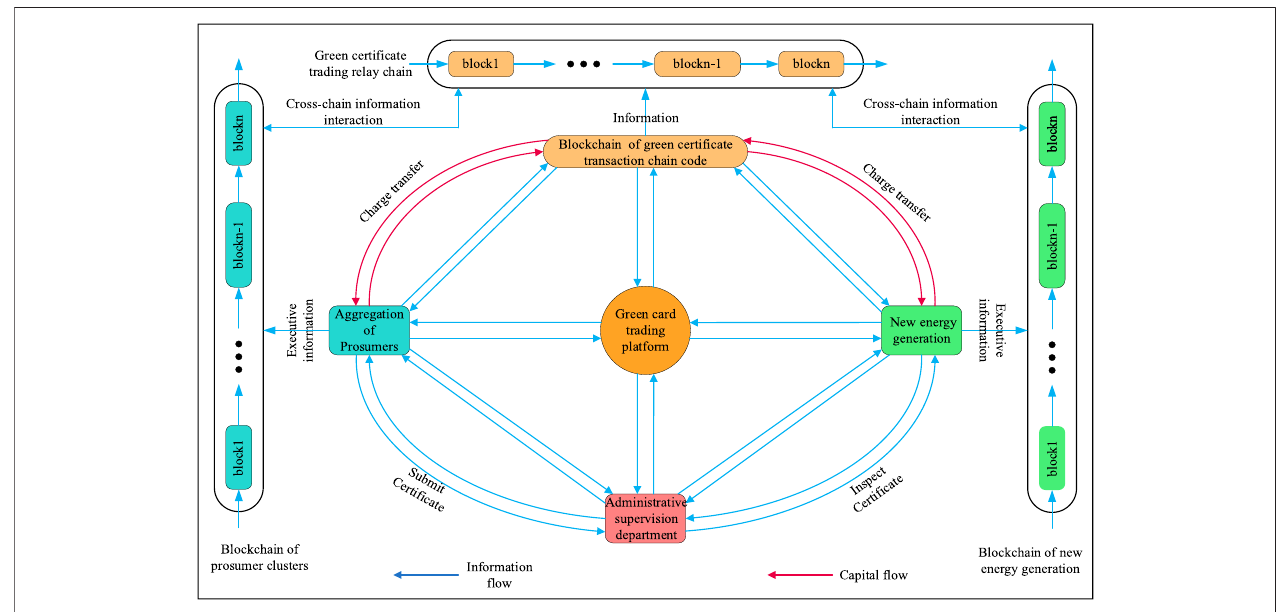
FIGURE 3 | Green certi fi cate transaction